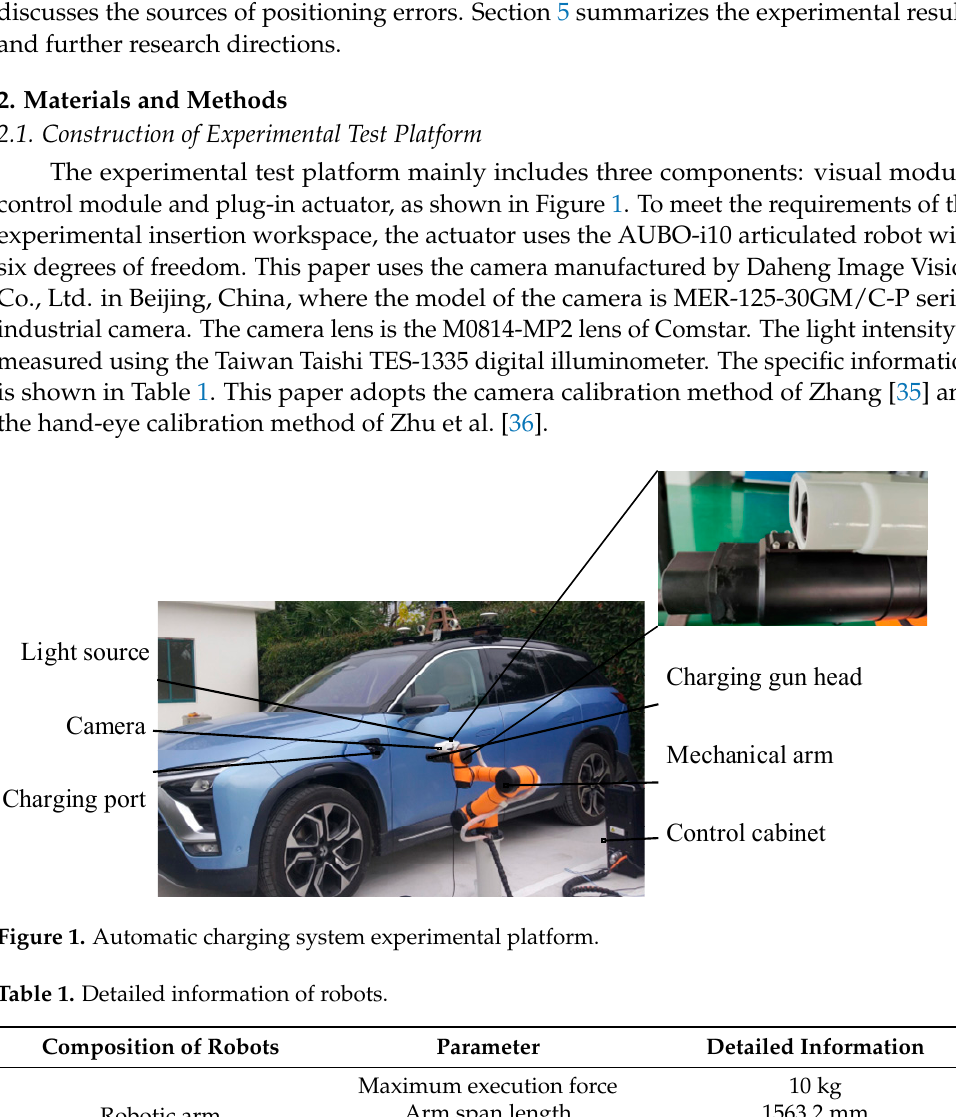
Table 1. Detailed information of robots.